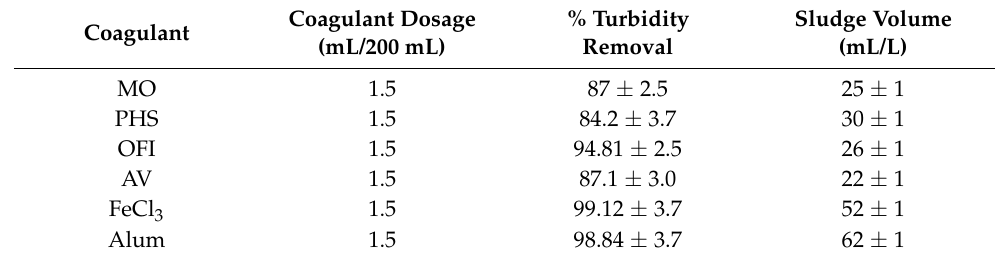
Table 3. Comparison of bio-coagulant sludge production with FeCl 3 and Alum. (Mean ± SD, n =